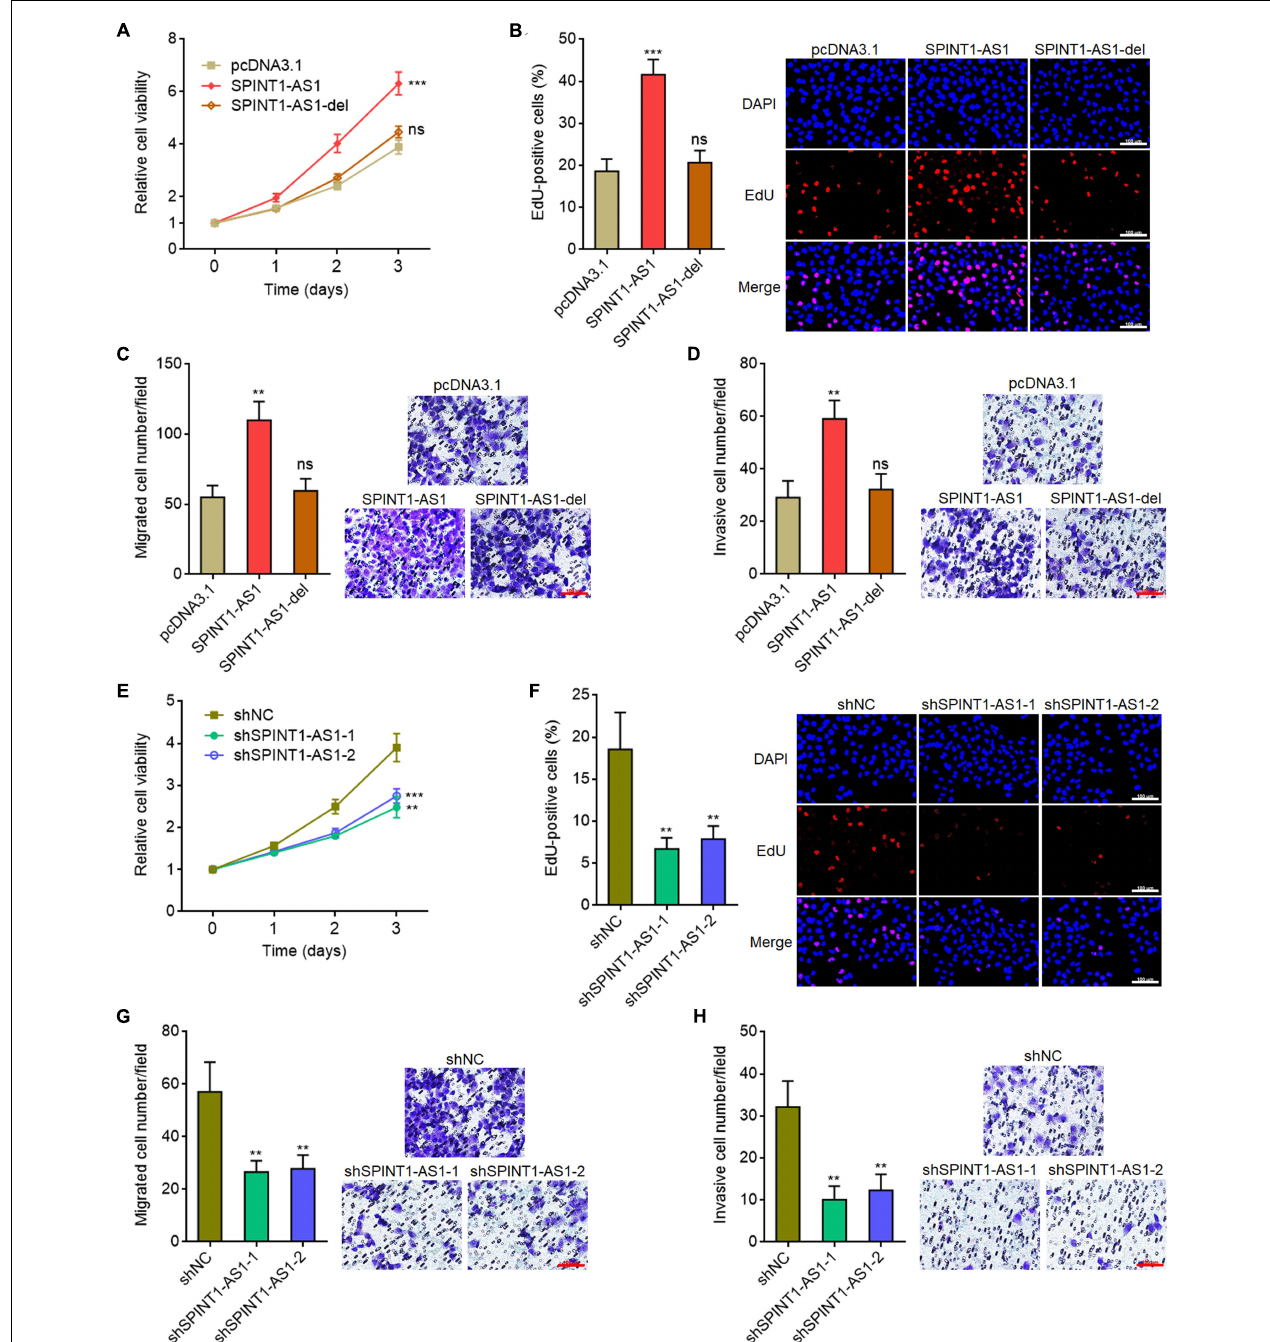
FIGURE 4 | SPINT1-AS1 drove cervical cancer cellular proliferation, migration, and invasion in a miR-214 dependent manner. (A) Cell viabilities of HeLa cells with SPINT1-AS1 or 5 (cid:48) 70 nucleotides deleted SPINT1-AS1 (SPINT1-AS1-del) stable overexpression were detected using Glo cell viability assay. (B) Cell proliferation of HeLa cells with SPINT1-AS1 or SPINT1-AS1-del stable overexpression was evaluated using EdU staining. Scale bars, 100 µ m. (C) Cell migration of HeLa cells with SPINT1-AS1 or SPINT1-AS1-del stable overexpression was evaluated using transwell migration assay. Scale bars, 100 µ m. (D) Cell invasion of HeLa cells with SPINT1-AS1 or SPINT1-AS1-del stable overexpression was evaluated by transwell invasion assay. Scale bars, 100 µ m. (E) Cell viabilities of HeLa cells with SPINT1-AS1 stable silencing were detected by Glo cell viability assay. (F) Cell proliferation of HeLa cells with SPINT1-AS1 stable silencing was evaluated by EdU staining. Scale bars, 100 µ m. (G) Cell migration of HeLa cells with SPINT1-AS1 stable silencing was evaluated by transwell migration assay. Scale bars, 100 µ m. (H) Cell invasion of HeLa cells with SPINT1-AS1 stable silencing was detected by transwell invasion assay. Scale bars, 100 µ m. Results are shown as mean ± SD based on three independent experiments. ** P < 0.01, *** P < 0.001, ns, not significant, by one-way ANOVA followed by Dunnett (cid:48) s multiple comparisons test.